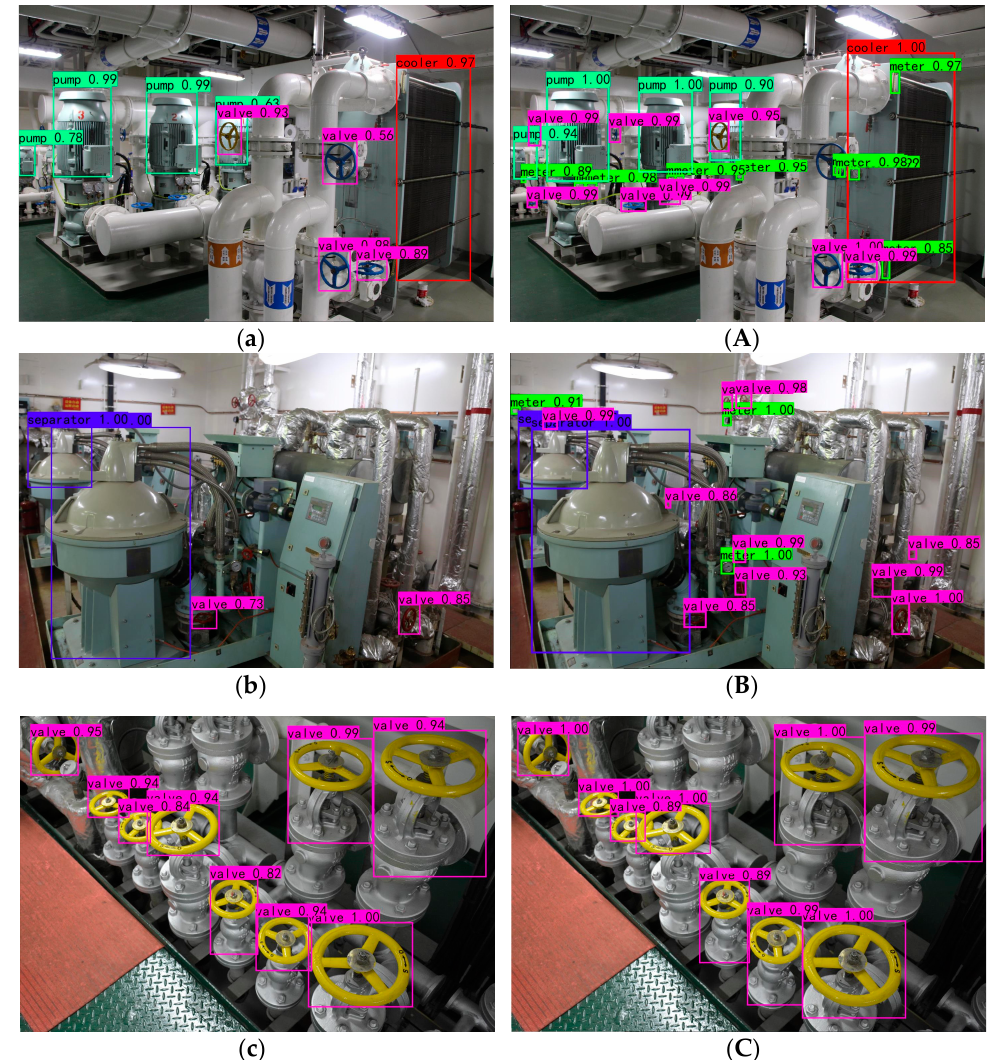
Figure 16. Detection results visualization in actual scenes. The images of ( a – c ) are detection results of baseline YOLOv5, while ( A – C ) are detection results of improved YOLOv5.